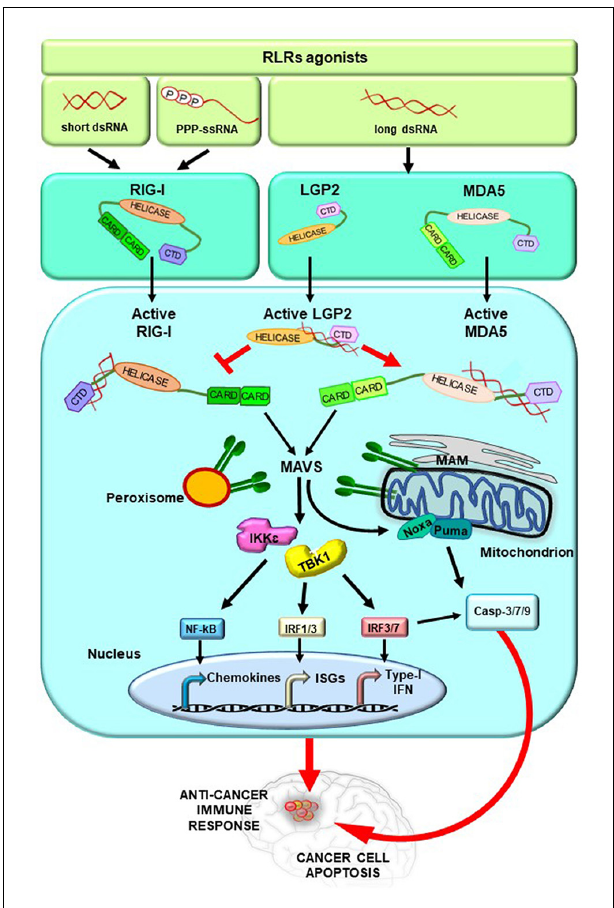
FIGURE 2 | RLRs signaling pathway activation. Upon binding of immunostimulatory RNAs, RLRs undergo conformational changes leading them to an active state. These events are tightly regulated by ubiquitylation and phosphorylation processes (not shown for simplicity) and by the action of LGP2, which stimulates MDA5 and inhibits RIG-I. The activation of RIG-I and MDA5 induces the exposition of their CARDs for the interaction with MAVS. MAVS is located on mitochondria, mitochondrial-associated membranes (MAM), and peroxisomes and transduces the signal to TANK-binding kinase 1 (TANK1) and IkB Kinase ε (IKK ε ). Subsequently, the interferon regulatory factors 1, 3, and 7 (IRF1, 3, and 7) are activated together with the transcription factor nuclear factor- κ B (NF- κ B), leading to the expression of type I interferon (IFN) and other genes, such as IFN-stimulated genes (ISGs). In addition, activated MAVS promotes intrinsic/mitochondrial apoptosis through the expression of the pro-apoptotic genes Noxa and Puma , whose encoded proteins finally induce the cleavage of the caspases 3, 7, and 9 into the active forms. Overall, these molecular events stimulate anticancer immune response and lead to cancer cell